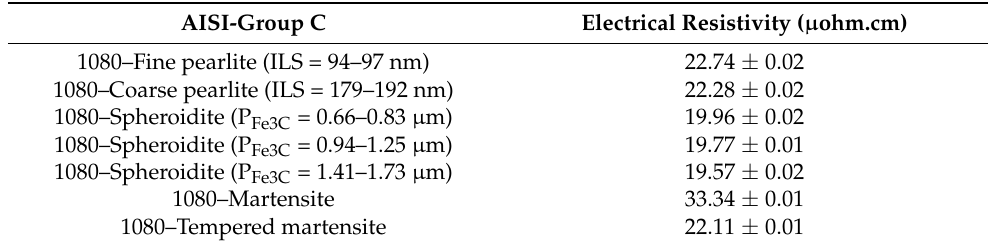
Table 7. Electrical resistivity measurements of AISI 1080 steels of group C performed at a controlled temperature of 35 ◦ C.